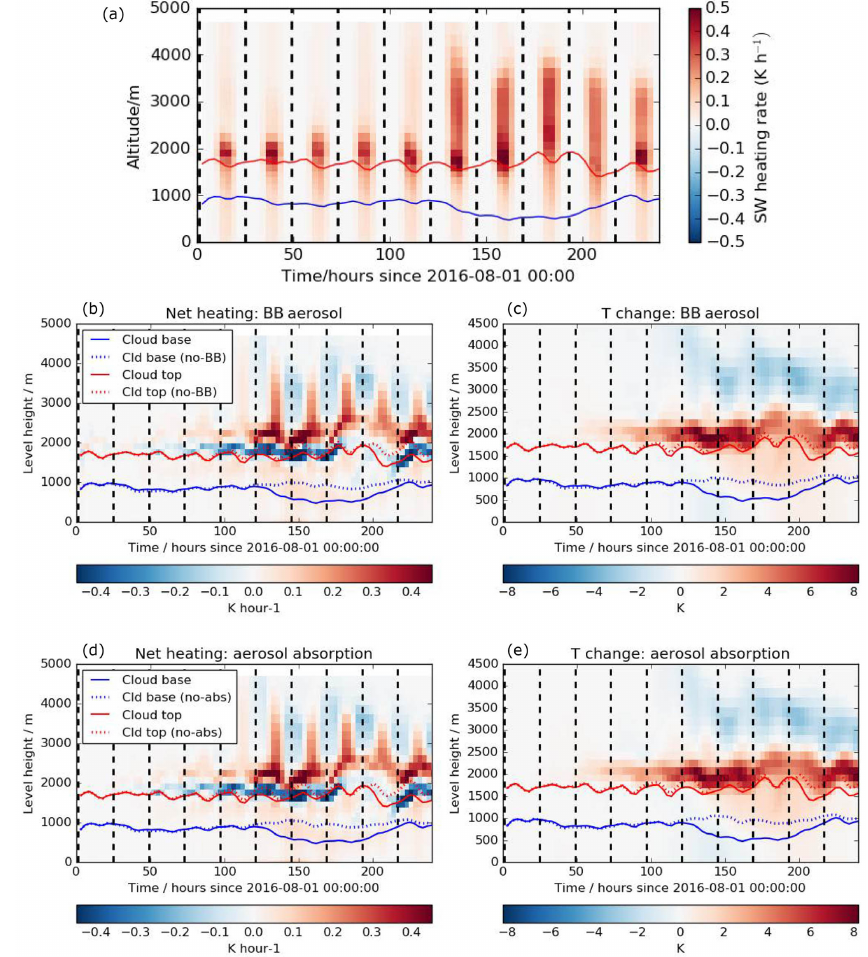
Figure 12. Regional average shortwave heating rate (a) and changes to heating rate and temperatures when biomass burning aerosol is introduced to the regional model (b, c) and when aerosol absorption of radiation is switched on (d, e) . The domain mean cloud top and cloud base heights in the simulations used are marked on the plots. On each day, midnight local time is indicated by a black dotted line.